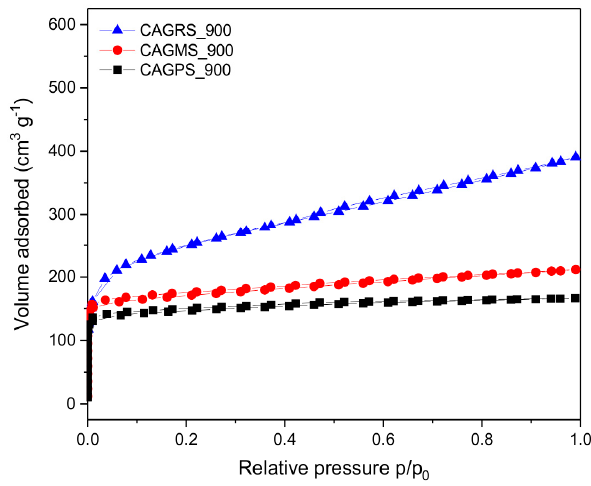
Figure 7. Nitrogen sorption isotherms of CAGPS, CAGMS, and CAGRS carbonized at 900 °C.